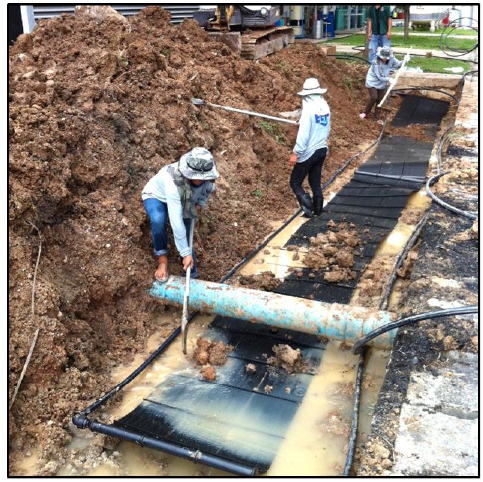
Figure 4. Carpet-type heat exchanger installation.